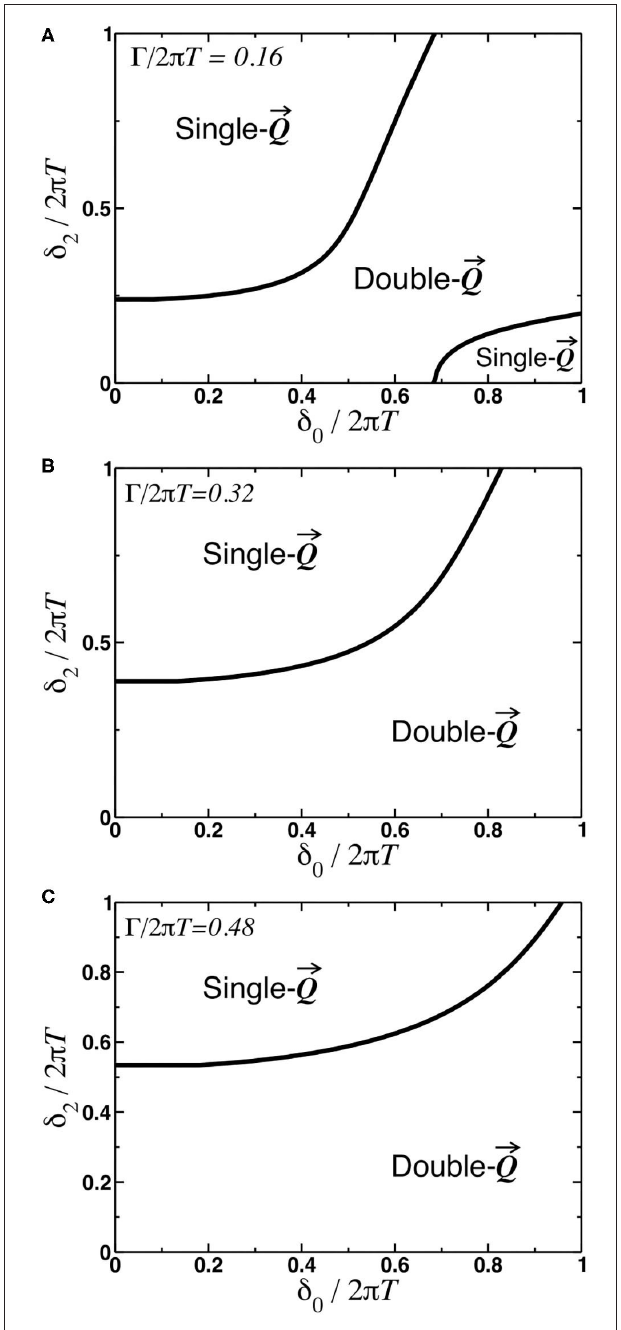
FIGURE 4 | Results of the numerical analysis of the coefficient g 4 in the free energy expansion for the disordered system: (A) Ŵ/ 2 π T 0.16; (B) = Ŵ/ 2 π T 0.32; (C) Ŵ/ 2 π T 0.48. With the increase in the value of the = = disorder scattering rate, the single- E Q state is a ground state for higher and higher values of the anisotropy parameter δ 2 which accounts for the ellipticity of the electron-like